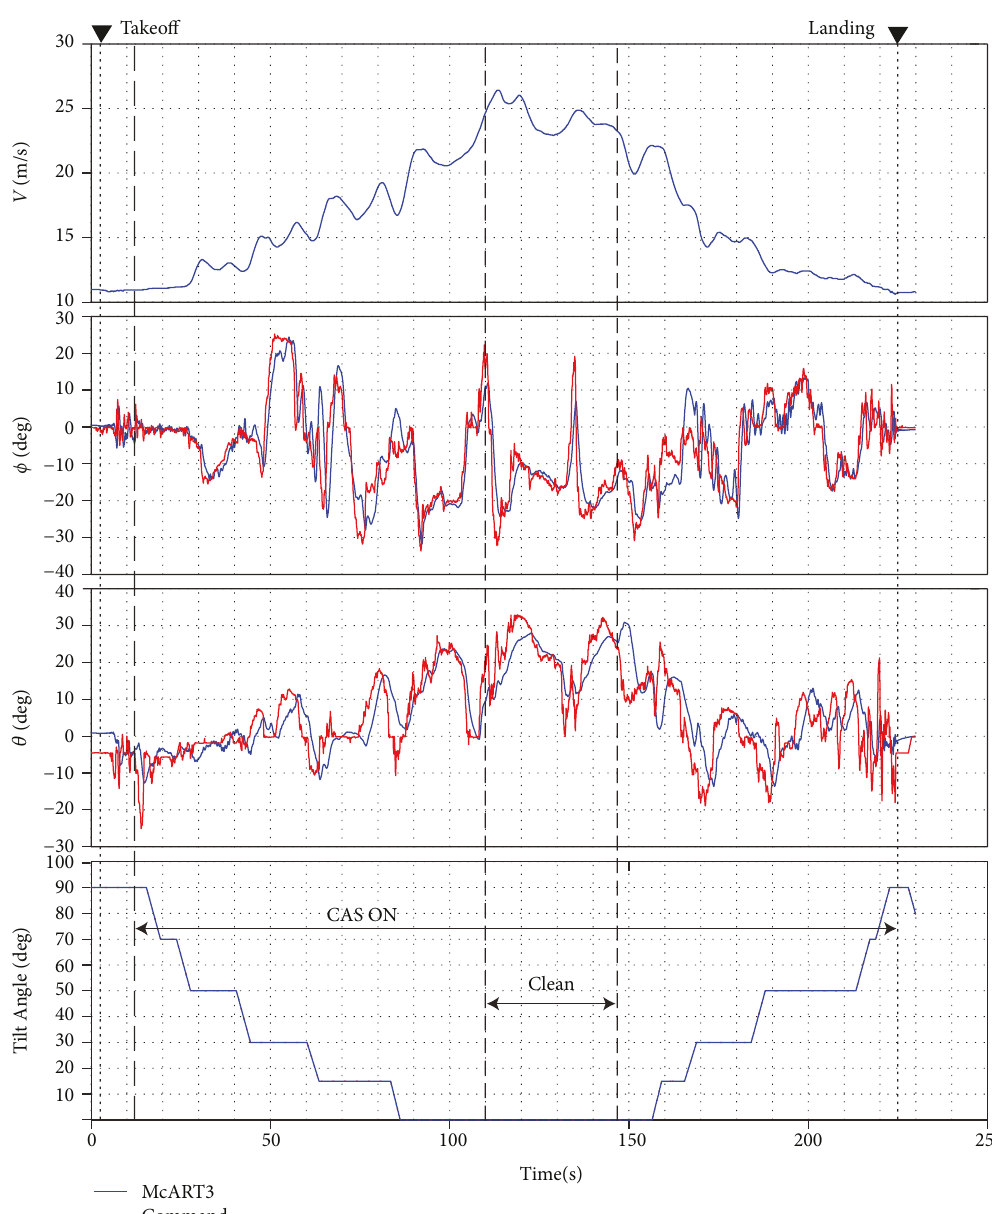
Figure 1: Time history of McART3 full conventional fl ight with a fl ight controller in